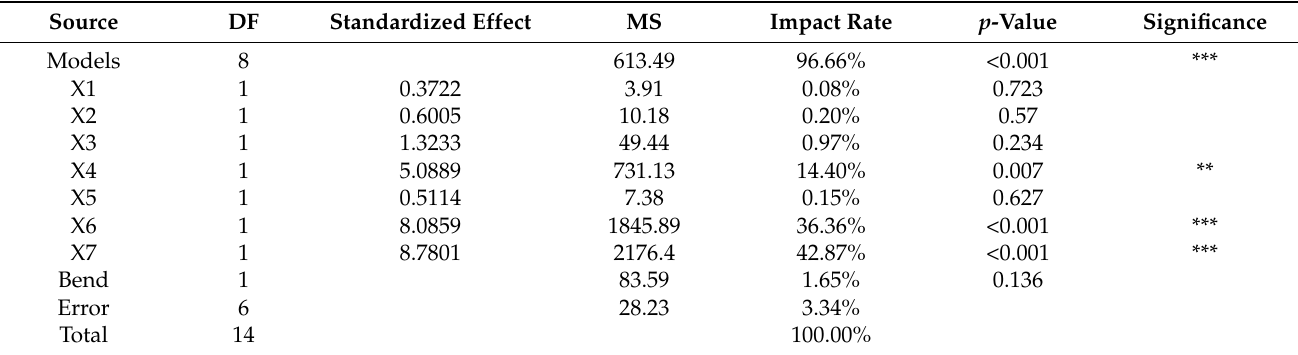
Table 7. Analysis of Plackett–Burman test results.